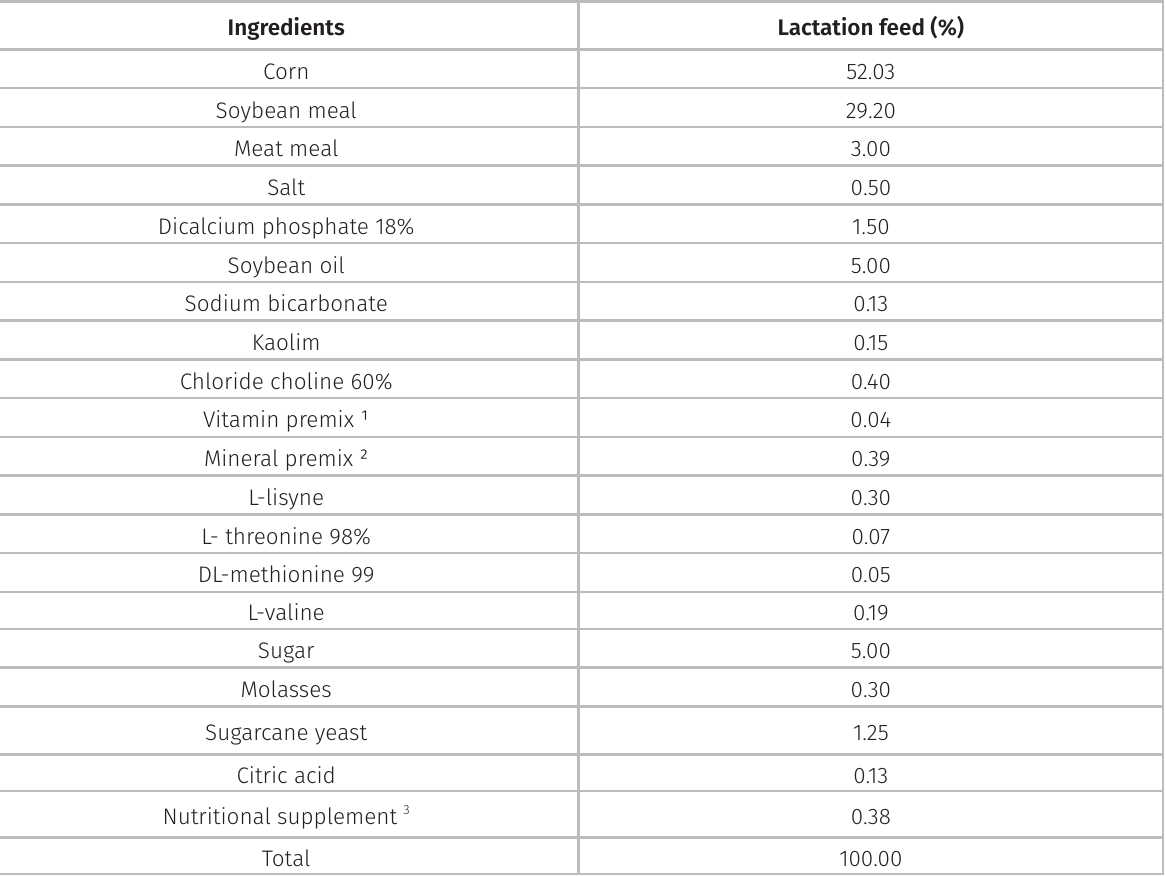
Table I. Formula and centesimal composition of the lactation feed of the sows.